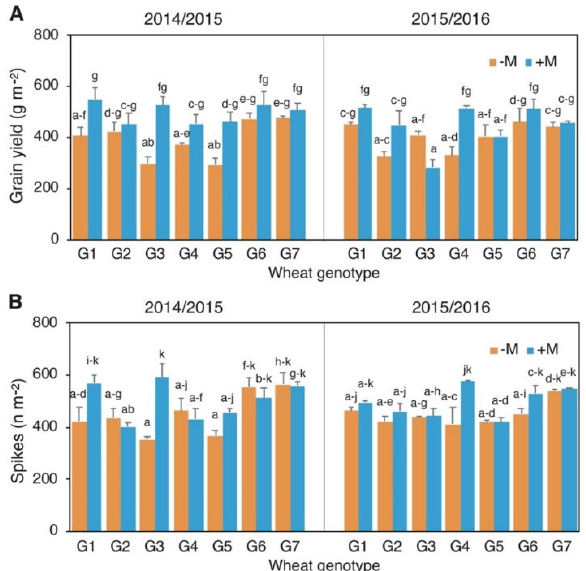
Figure 3. Effect of the interaction among wheat genotype (G), arbuscular mycorrhizal fungal inoculation (AMF), and year of cultivation (Y) (G × AMF × Y) on grain yield ( A ) and number of spikes per m 2 ( B ). − M: mock-AM fungal inoculated treatment (control); +M: AM fungal inoculated treatment. Wheat genotypes: G1: Gentil Rosso; G2; Risciola; G3: Frassineto; G4: Autonomia B; G5: Verna; G6: Blasco; G7: Bologna. Data are mean ± SE. Different letters indicate significant differences at P < 5% according to Tukey B test.